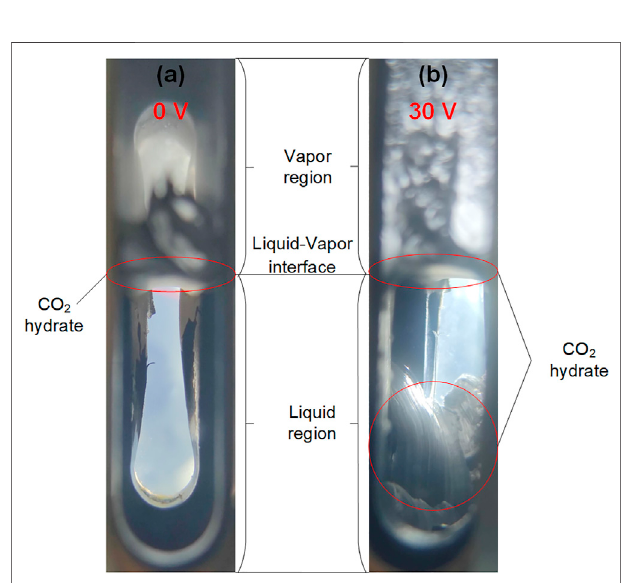
FIGURE 3 | Morphology of CO 2 hydrate formation in the application of 0 and 30 V without stirring at 3.5 MPa and 274.15 K. (A) 0 V, (B) 30 V.